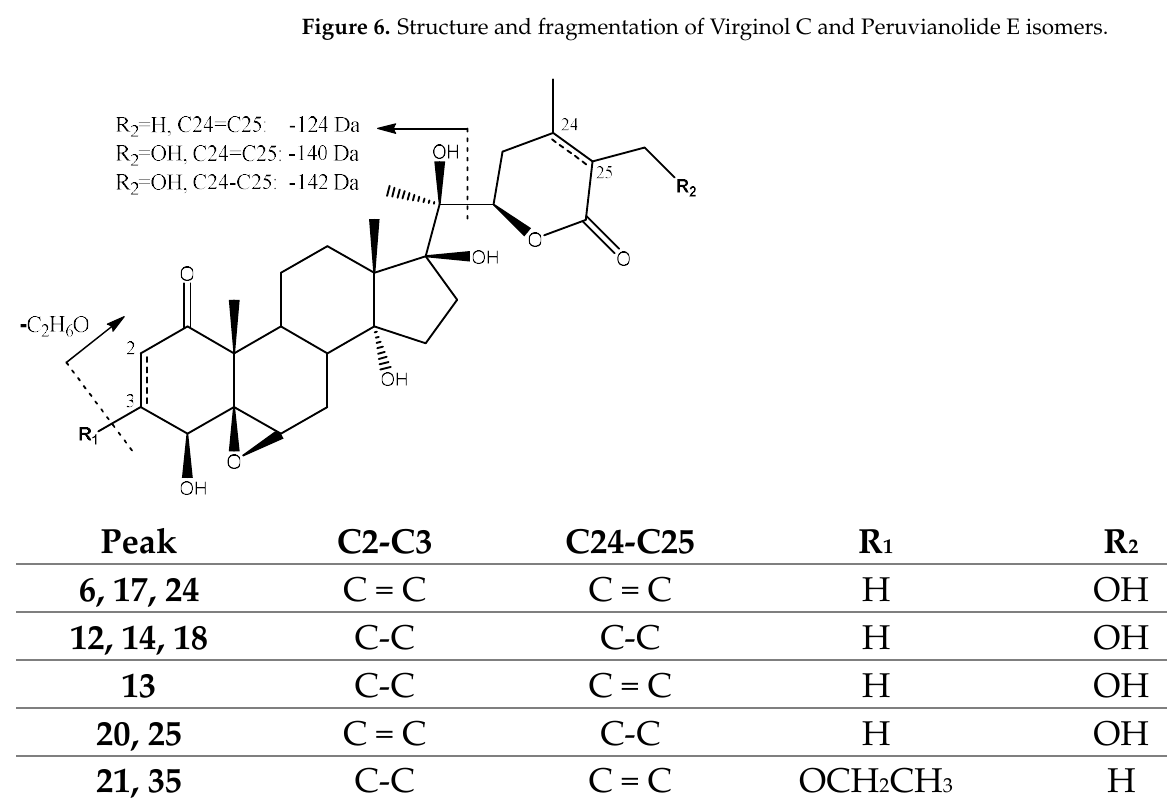
H Figure 7. Structure and fragmentation of withanolide E derivatives hydroxylated in C-27.